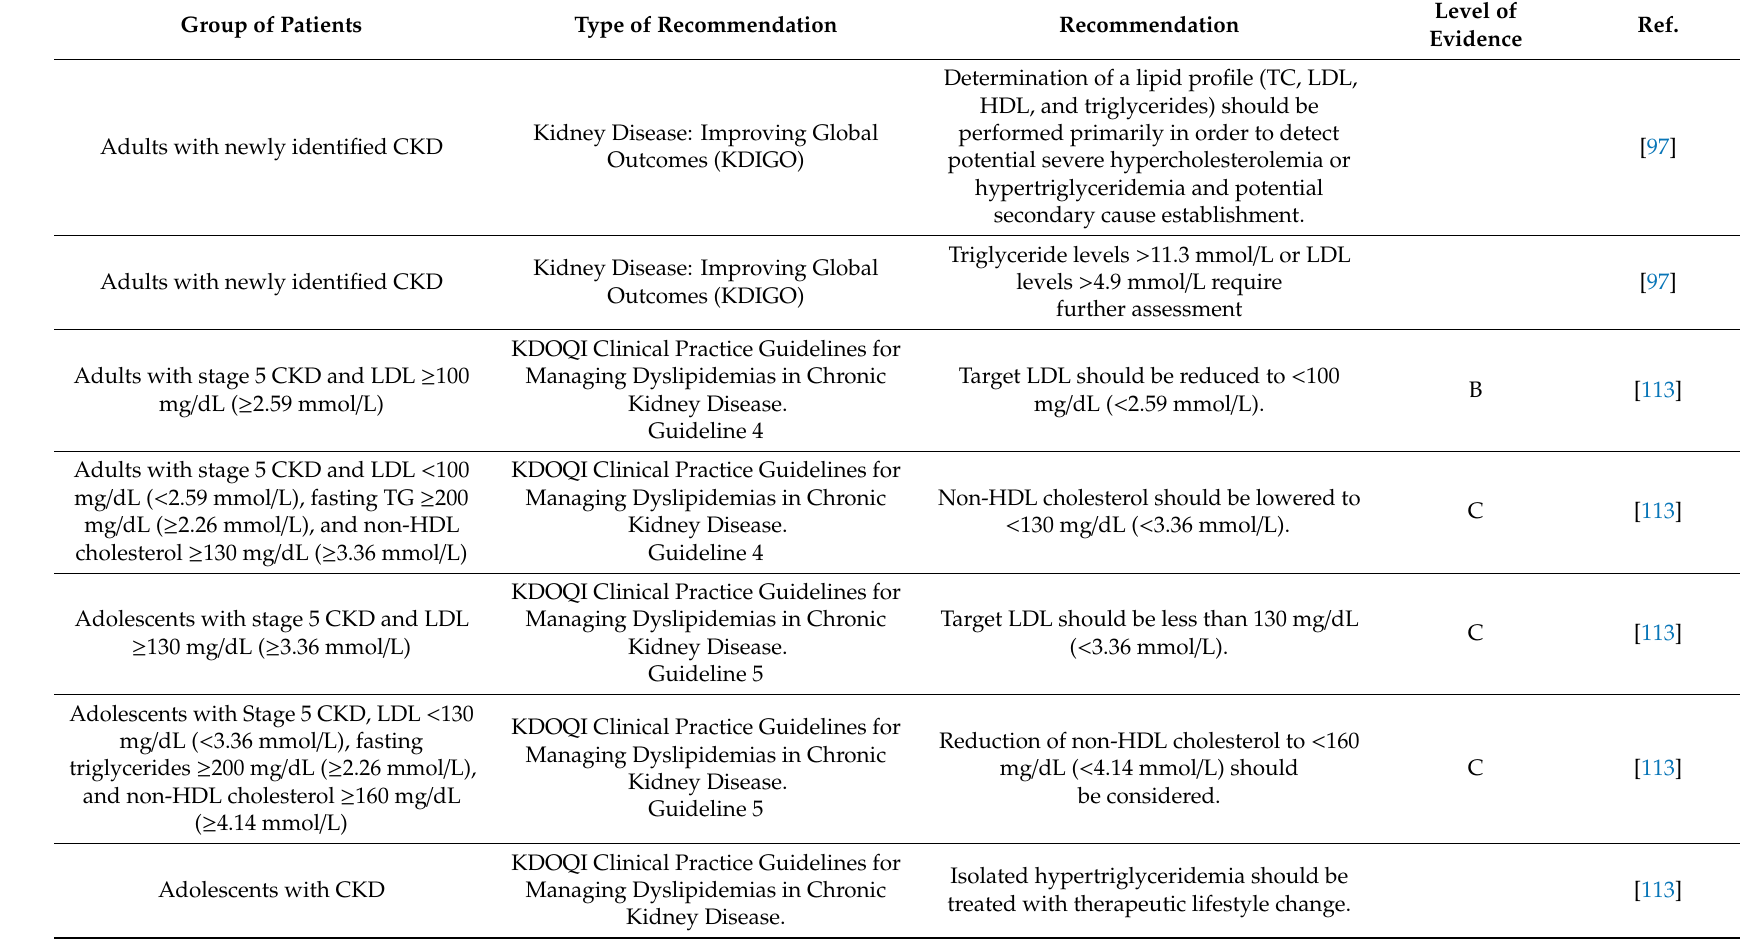
Table 2. Summary of guidelines concerning lipid disorders in